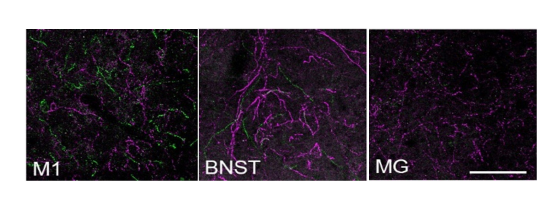
FIGURE3 Locus coeruleus efferent fibers in TrAC-LC mice following CAV2-Cre injection in medial prefrontal cortex. tdTomato + fibers (magenta) and EGFP + fibers (green) are shown in primary motor cortex (M1), bed nuc stria terminalis (BNST), medial geniculate (MG). Note the paucity of labeled fibers in MG, i.e.,